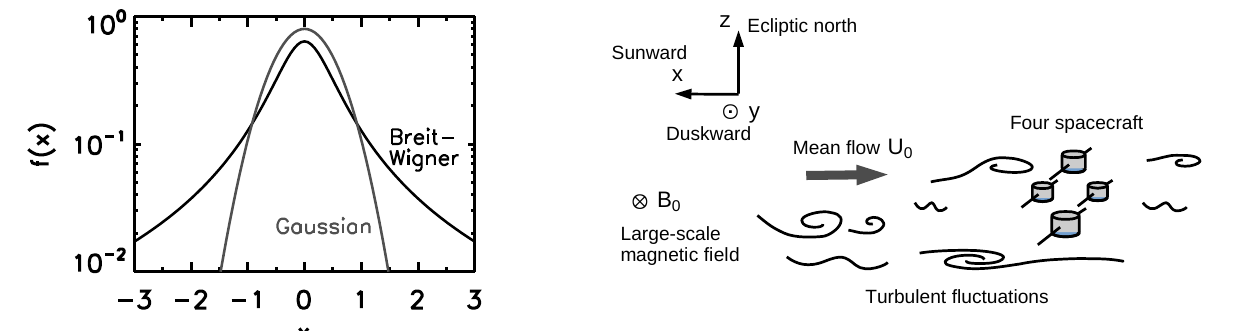
Figure 2. Sketch of the observational setup.